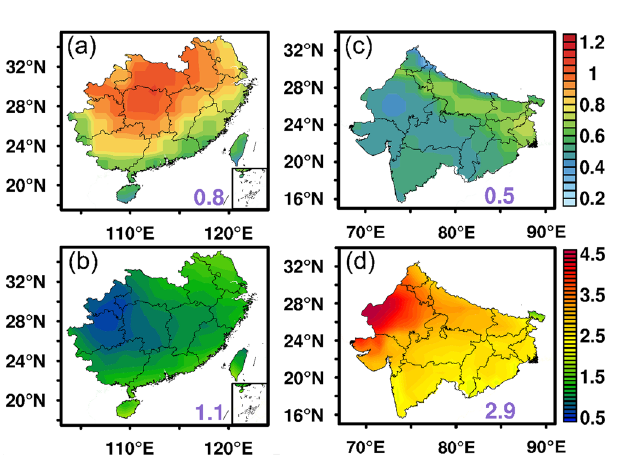
Figure 6. Diurnal variations of ( a , c ) cloud fraction and ( b , d ) cloud optical depth from 2003 to 2019 over the SC (left column) and NI (right column). Note the cloud optical depth has been weighted by the cloud fraction. The local time for the SC is Beijing time (UTC + 8:00), and the local time for the NI is India standard time (UTC + 5:30). The red and black dotted lines show the averaged sunrise time and the sunset time for the NI and SC regions, respectively.